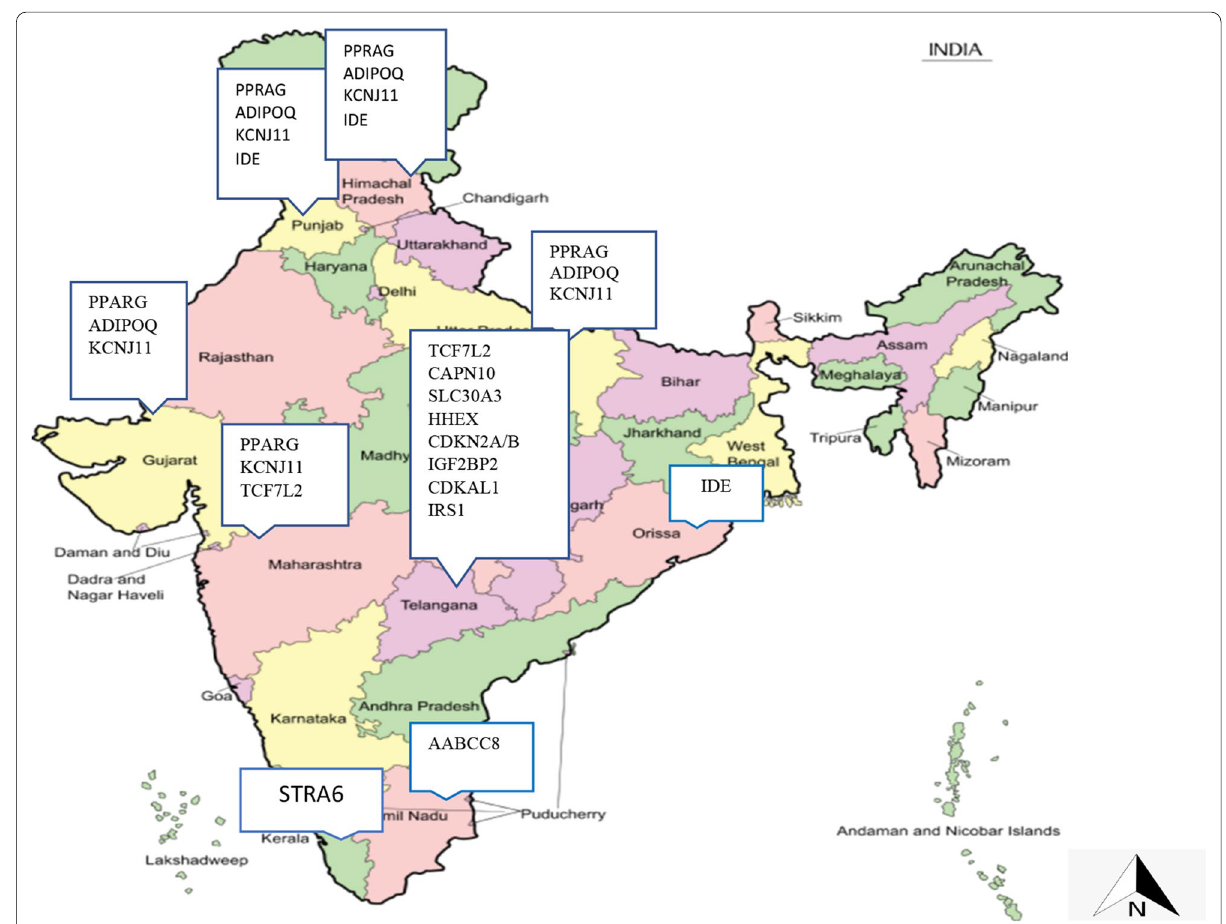
Fig. 2 Mapping of SNPs associated with T2DM in